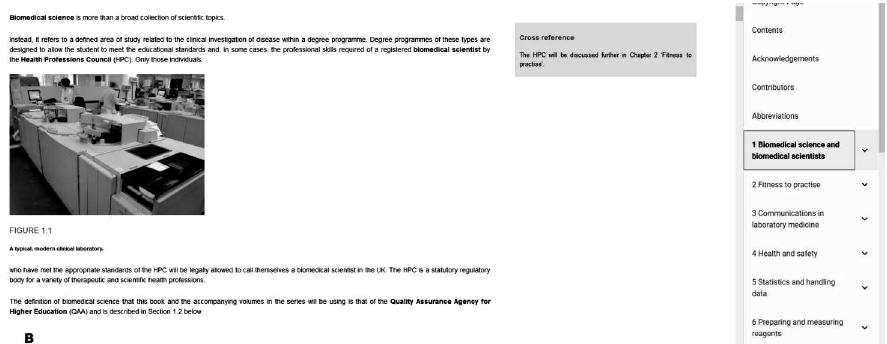
Figure 1. Non-interactive digital textbooks